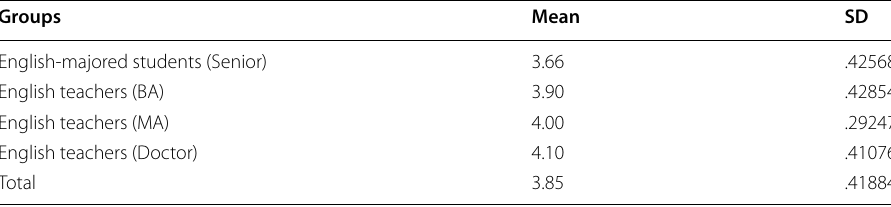
Table 5 The mean scores between and within groups Sum of squares df Mean square F Sig. Within